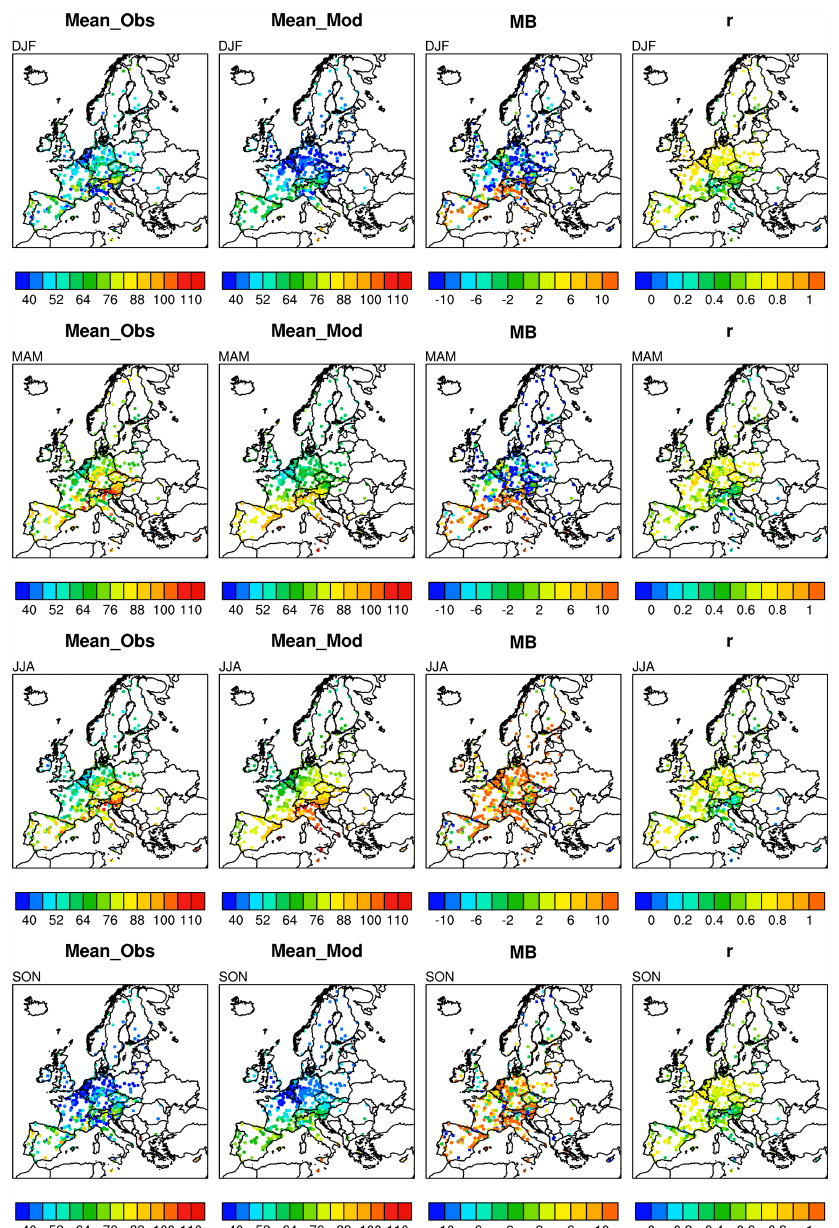
Figure 5. Seasonal average values of surface O 3 in µgm − 3 from hourly measurements at AirBase (circles) and EMEP (squares) stations, and modeled values from MOZART for corresponding locations. The Mean Bias (MB, in µgm − 3 ) and temporal correlation coefficient ( r ) for hourly values are also shown at the location of station